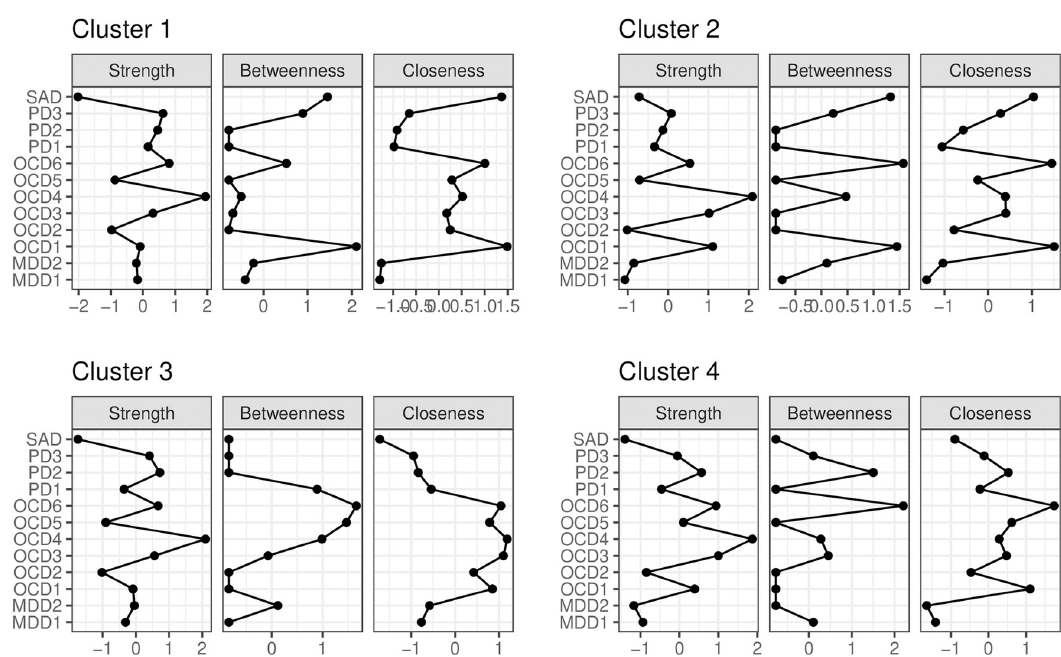
Fig 4. Centrality indexes (standardized z -scores) calculated in each partial correlation network. MDD = major depressive disorder, PD = panic disorder, SAD = social anxiety disorder, OCD = obsessive-compulsive disorder. MDD1 = cognitive/affective symptoms, MDD2 = somatic symptoms, PD1 = physical concerns, PD2 = cognitive concerns, PD3 = social concerns, OCD1 = hoarding, OCD2 = checking, OCD3 = ordering, OCD4 = neutralizing, OCD5 = washing, OCD6 = obsessing.